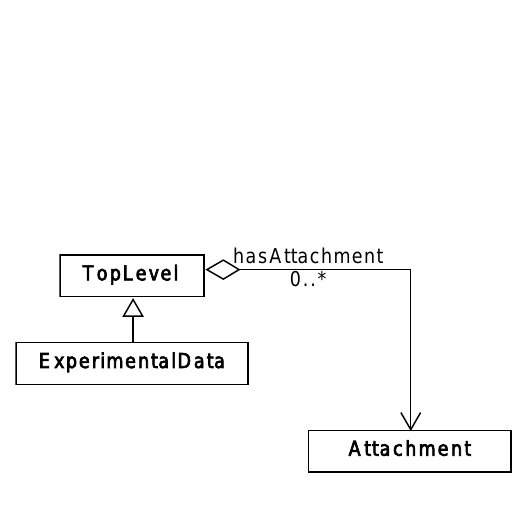
Figure 18: Diagram of the ExperimentalData class and its associated properties.